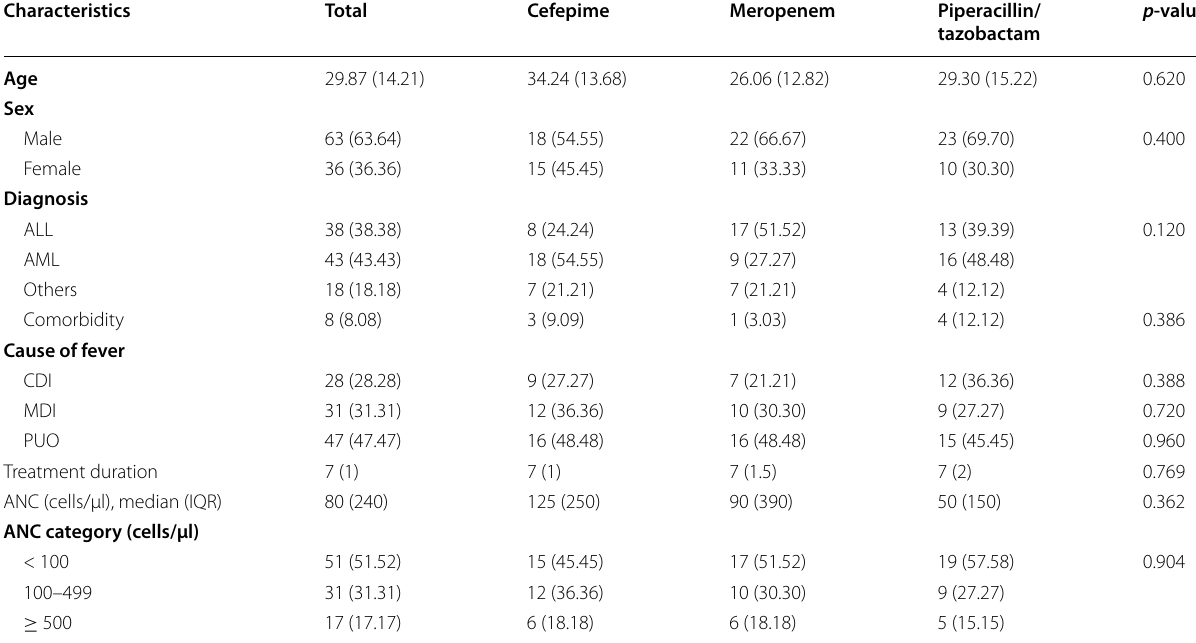
Table 1 Background characteristics of the patients ( n